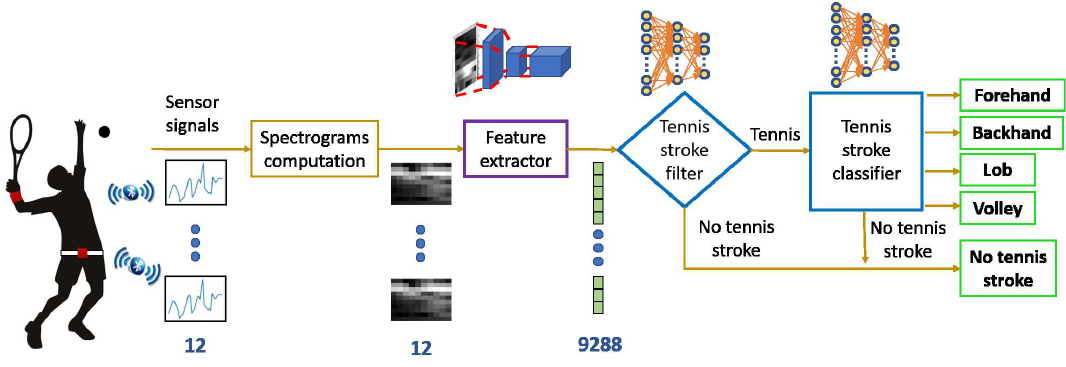
Figure 1. Detection of tennis strokes with wearable sensors and deep